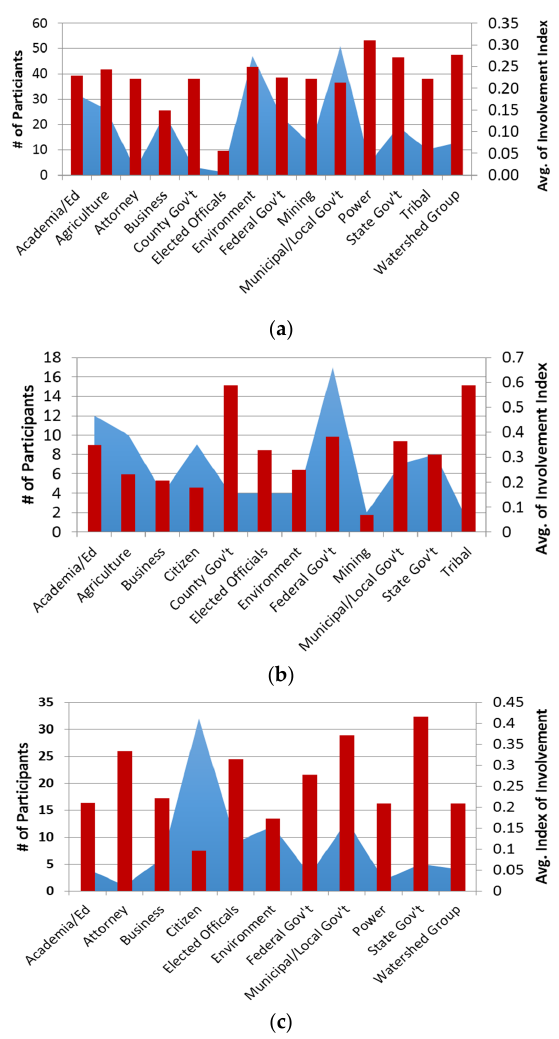
Figure 3. Evaluation of Participant Diversity and Involvement including number of participants ( blue ) and average of the involvement index ( red ) for each interest. ( a ) Roadmap; ( b ) Gila; ( c ) Clarkdale.